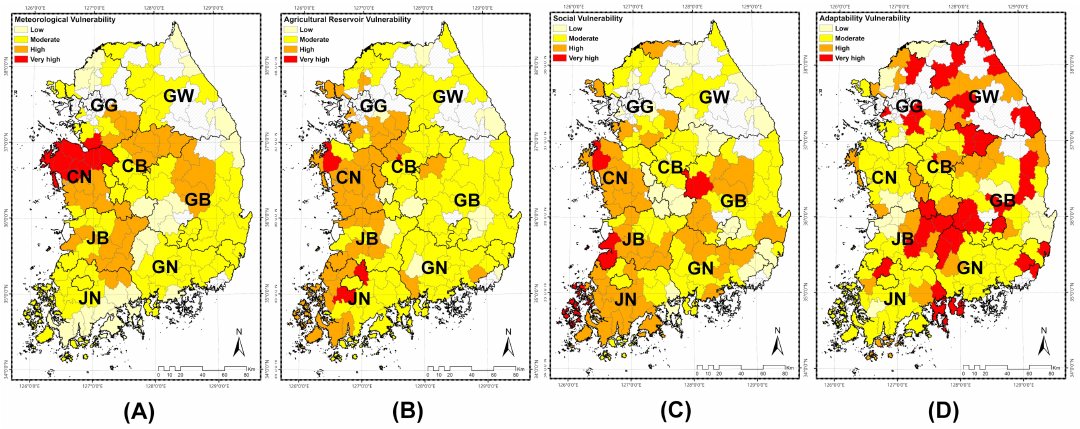
Figure 4. Vulnerability map by factors related to vulnerability to agricultural drought (( A ): meteorological vulnerability, ( B ): agricultural reservoir vulnerability, ( C ): social vulnerability, ( D ): adaptability